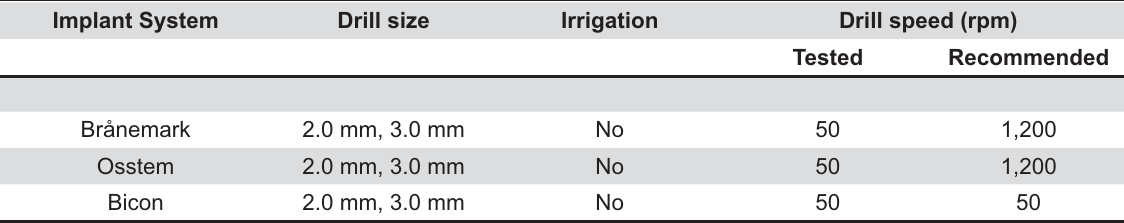
Table 1- Implant drilling systems tested in the study